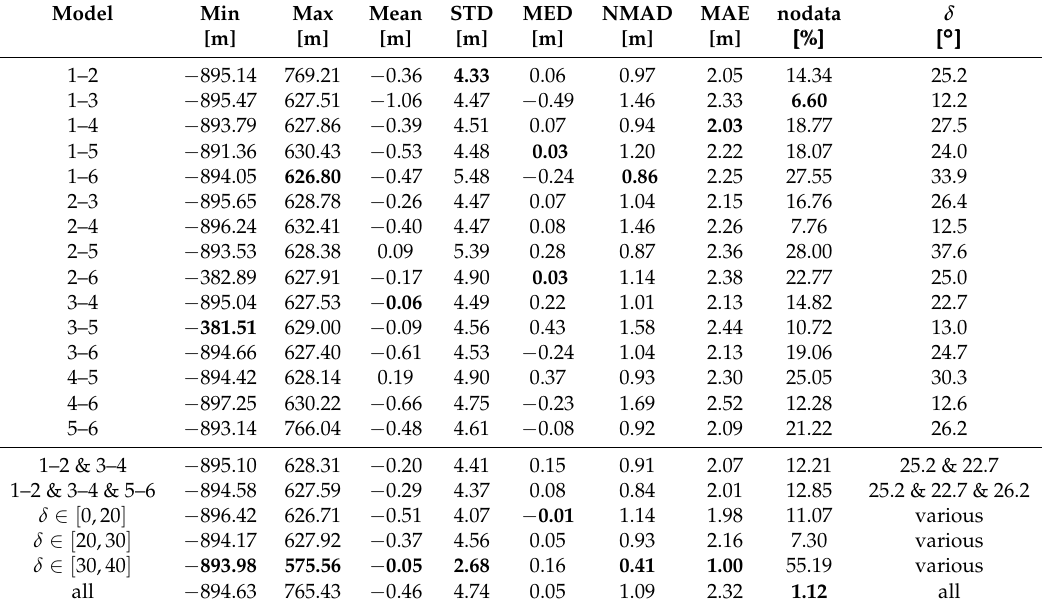
Table 12. Accuracy analysis of the resulting DSMs in comparison to LiDAR reference data (with δ being the convergence angle). Best results are shown in bold face for single stereo and for multi stereo